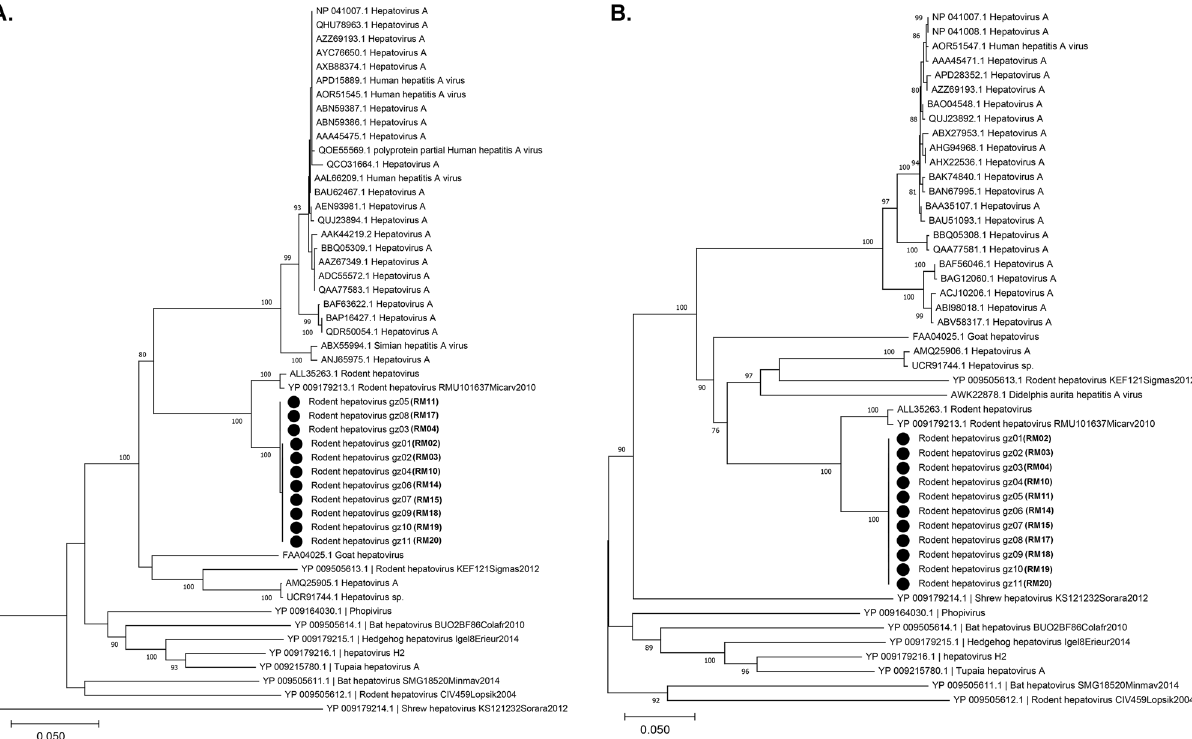
Figure 5. Phylogenetic relationships of hepatovirus variants based on analyses of the P1 protein ( A ) and 3CD protein ( B ). Branch lengths are drawn to a scale of aa substitutions per site. Numbers above individual branches indicate bootstrap support, only values > 80% are shown. Vole hepatovirus variants are marked by a black dot, sample ID were labeled in parentheses.